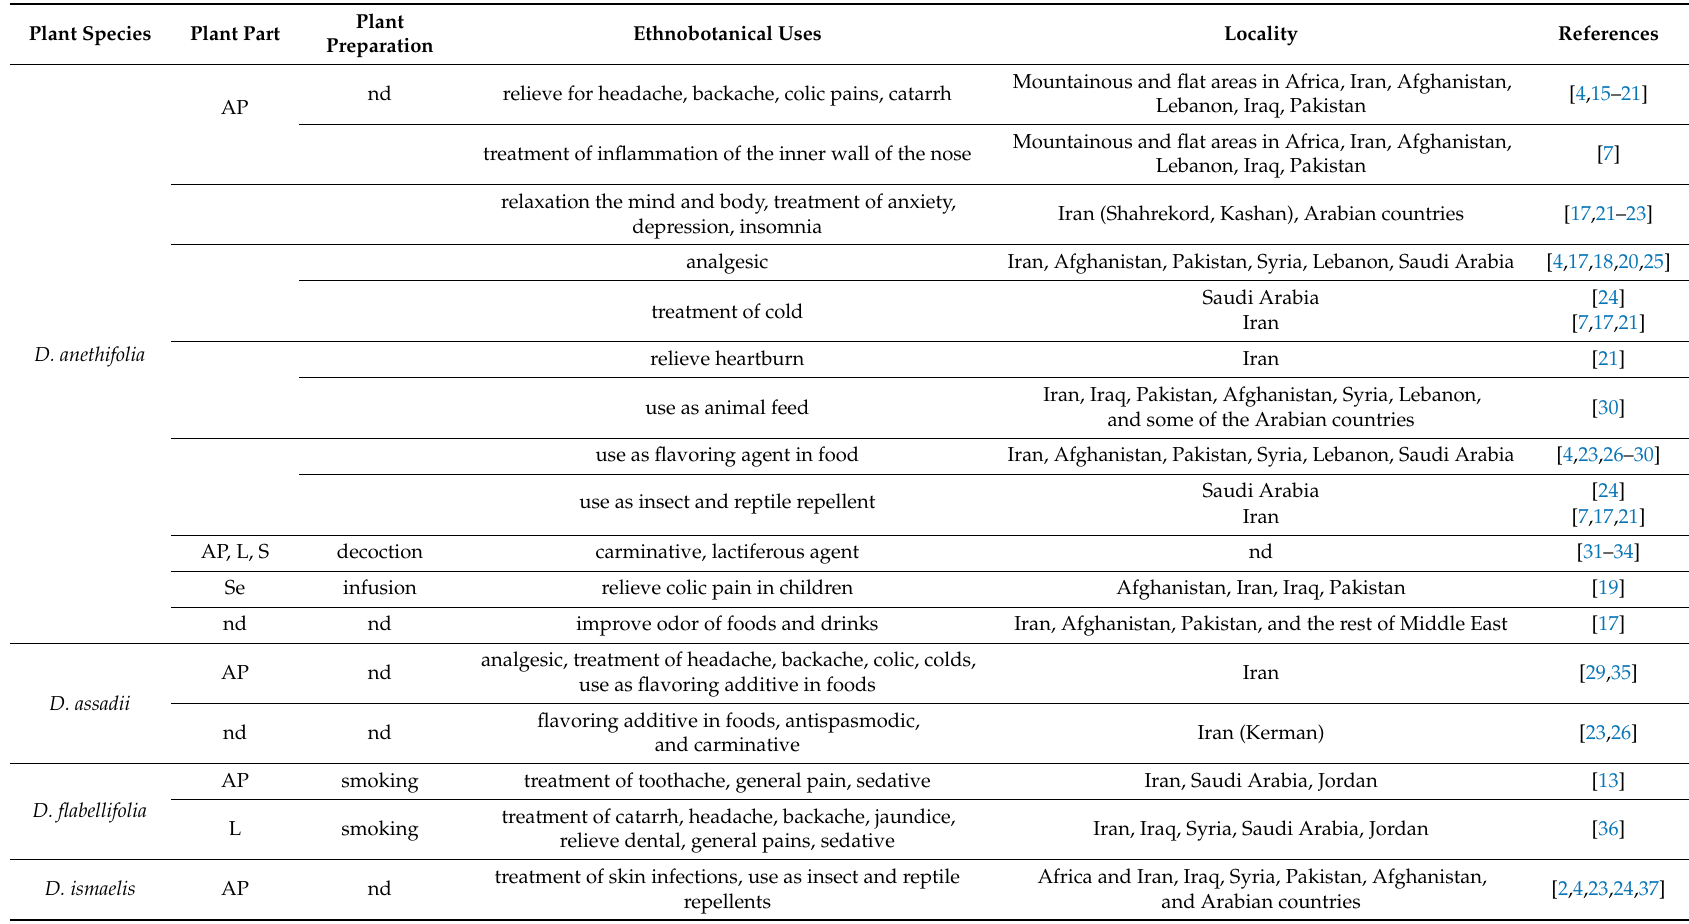
Table 1. The ethnobotanical application of Ducrosia